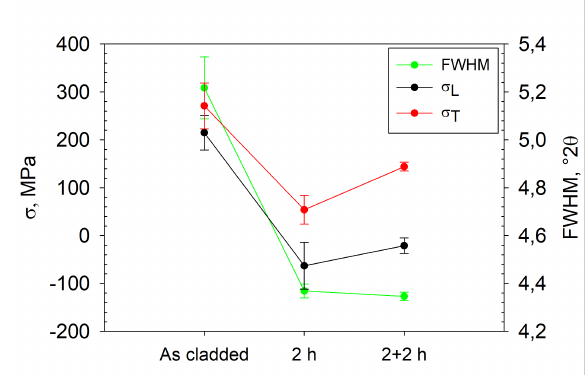
Figure 2. Surface RS and FWHM of the clad.